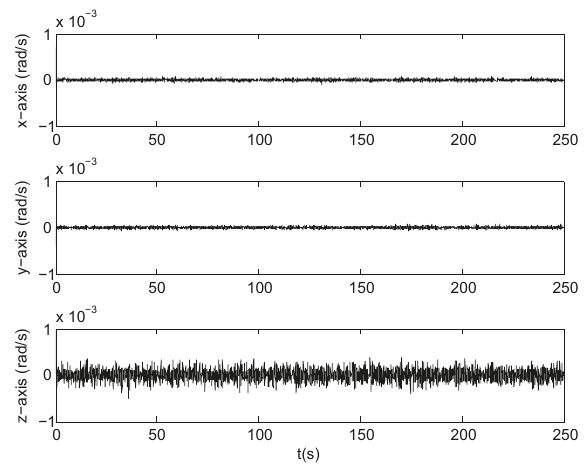
Figure 9. Angular velocity estimation errors in simulation.